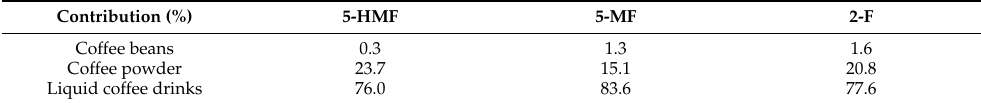
Table 5. The exposure contributions of furfural and its derivatives among Chinese